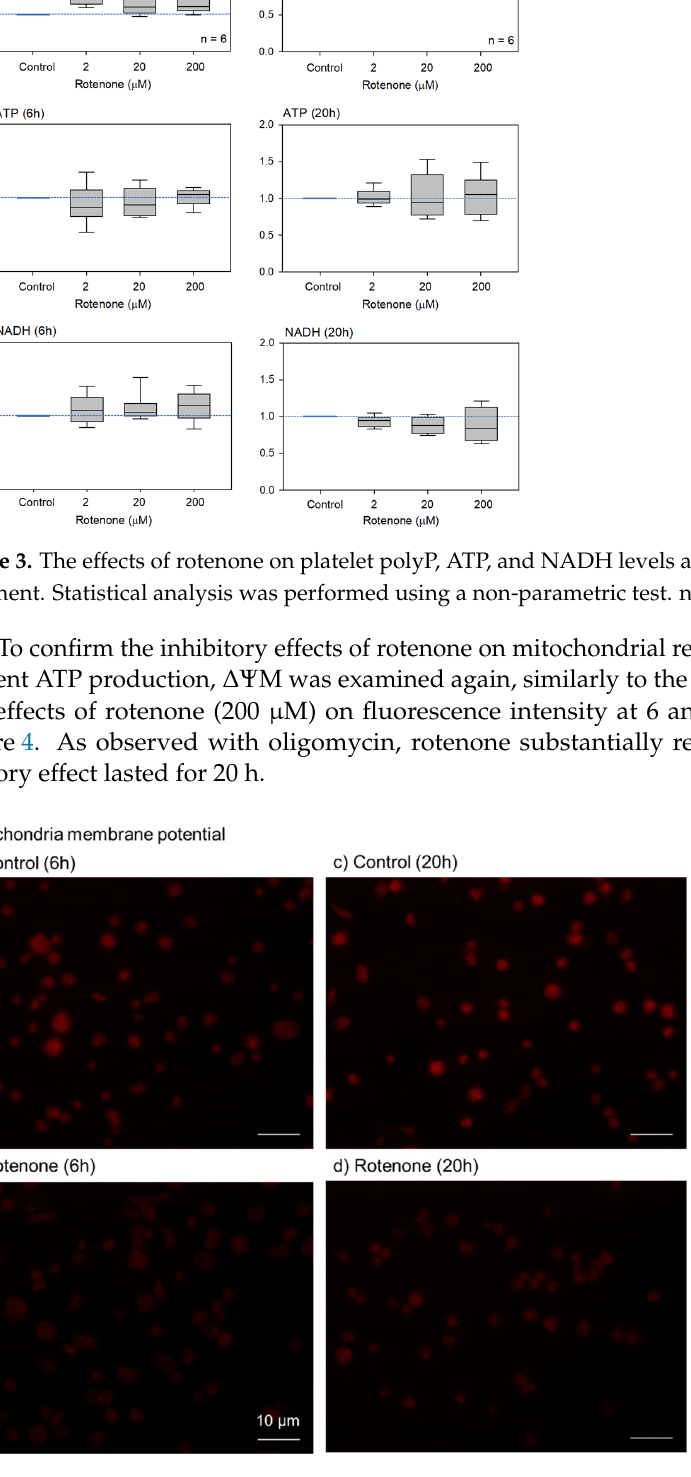
rotenone ( b , d ) for 6 h ( a , b ) or 20 h ( c , d ). The control contained only the solvent (DMSO) ( a , c ). Bar = 10 μ m. Similar results were observed in four other independent experiments.